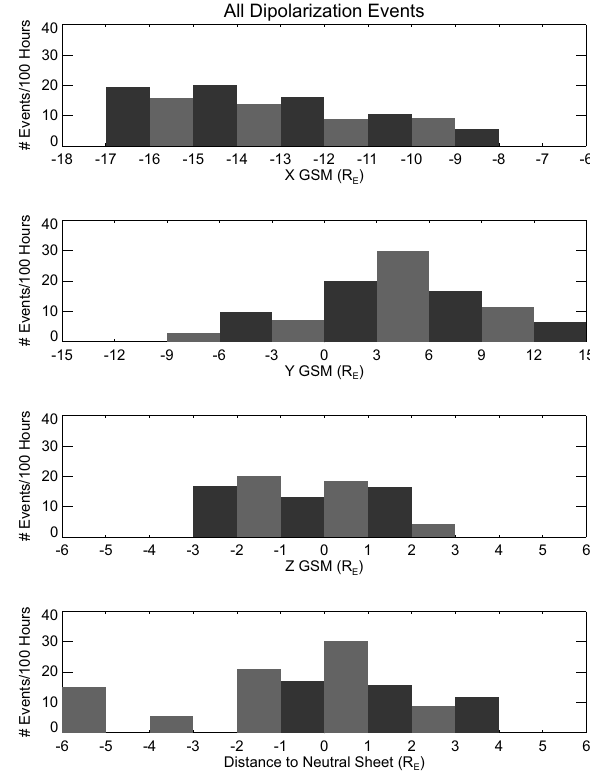
Fig. 6. The top 3 panels show histograms of the total amount of time in hours that the Wind spacecraft spent in different bins of the X , Y , and Z GSM position of the spacecraft. The bottom panel shows the amount of time Wind spent at different distances from the neutral sheet as determined by Fairfield (1980).